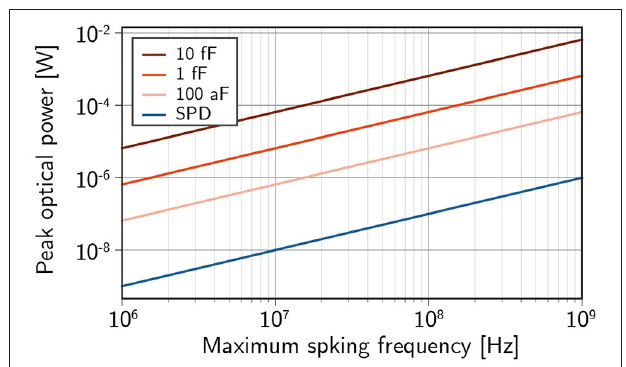
FIGURE 3 | The required optical power to drive 10 3 downstream synapses within one inter-spike interval for a given spiking frequency assuming receiverless photodiodes with optical link efficiency η